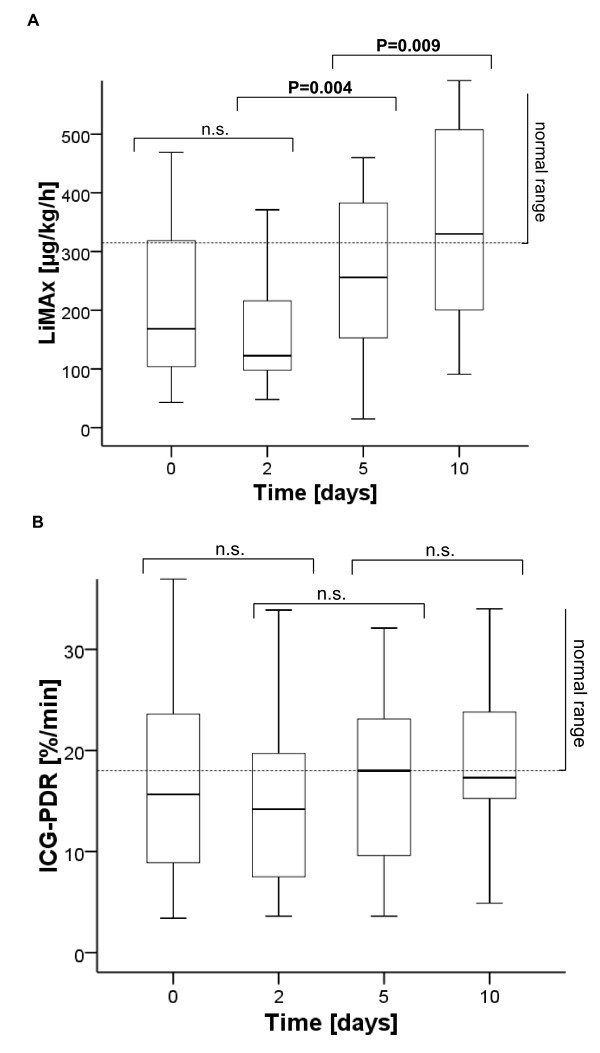
Overall progression of dynamic liver parameters during sepsis. (A) Maximal liver function capacity (LiMAx). (B) Indocyanine green plasma disappearance rate (ICG-PDR). Bold lines, medians; box plots, 25th to 75th percentiles.